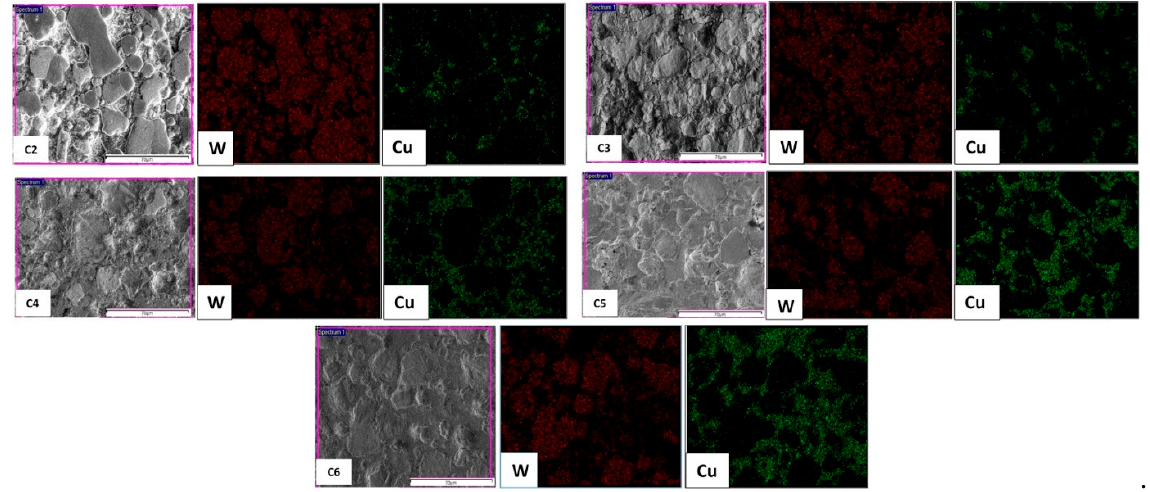
Figure 4. Elemental mapping of various compositions. Table 2. Grain size (of tungsten).